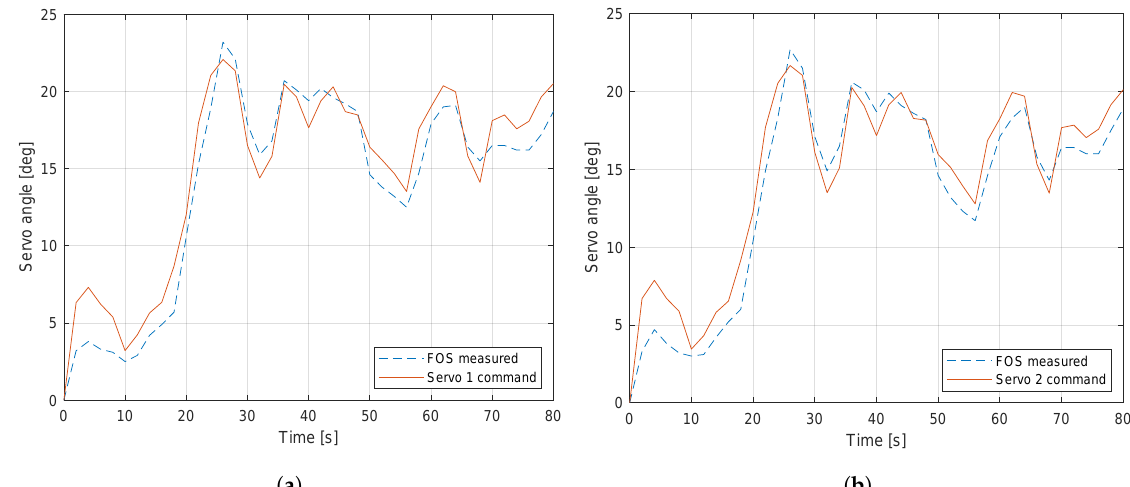
Figure 10. Estimated position with respect to module #1 deflections for the F y = 20 and M x = 0 case. The positions of actuators 1 and 2 are separated and shown in ( a , b ), respectively.